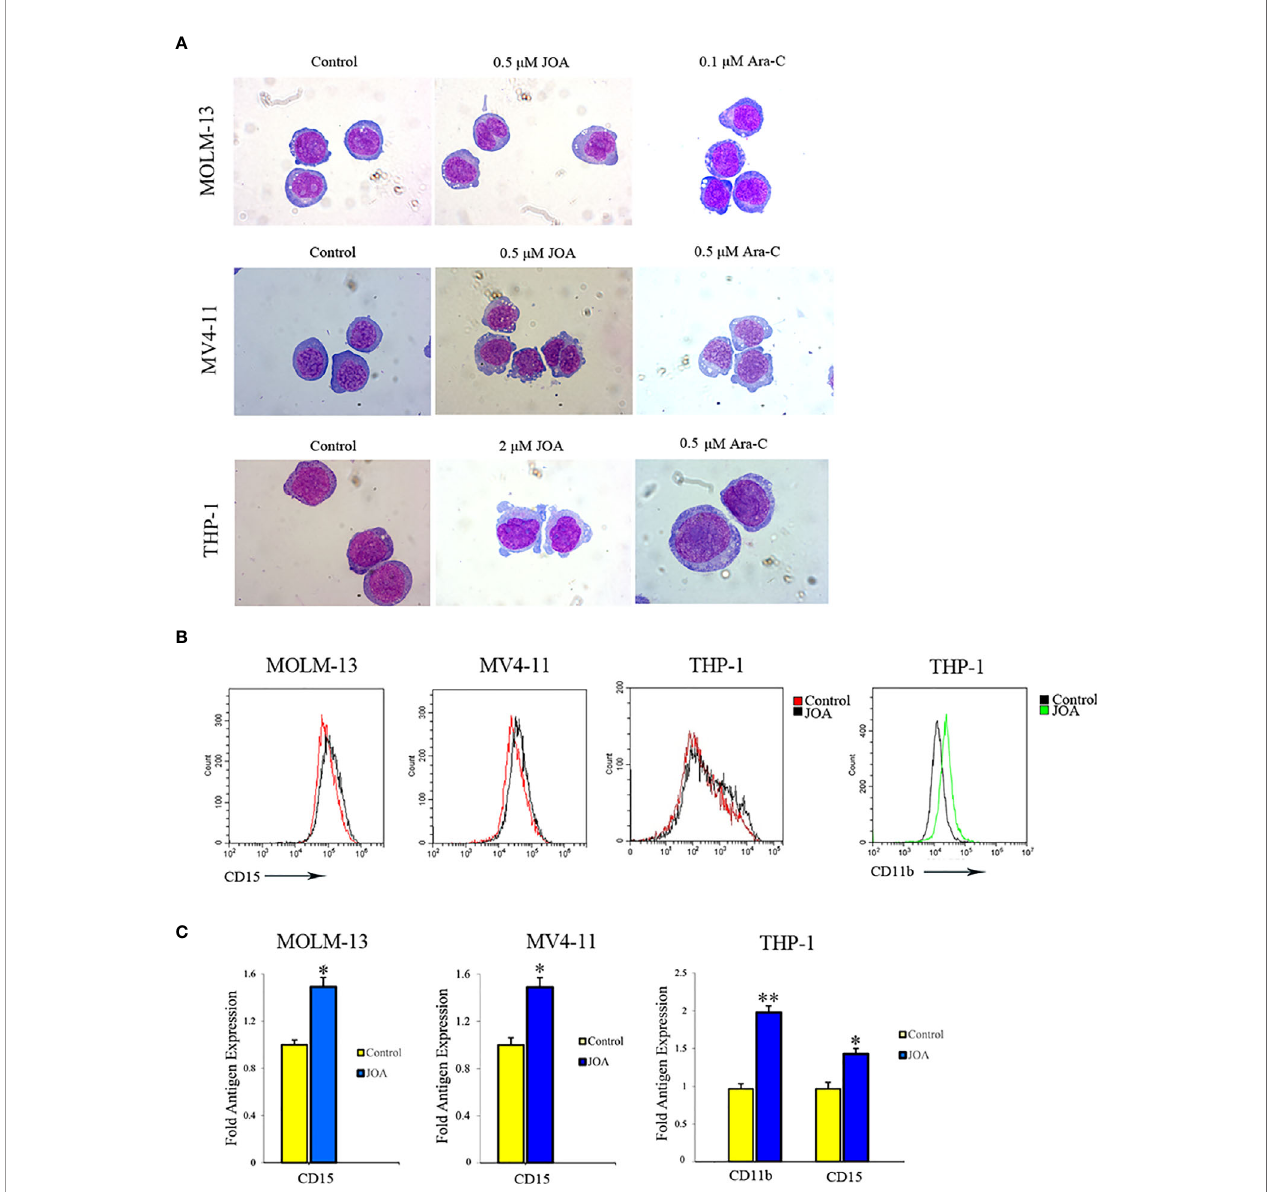
FIGURE 5 | JOA induces differentiation of MV4-11, MOLM-13 and THP-1 cells. (A) Wright-Giemsa staining images of cells captured by oil immersion lens (×1,000). (B) The expression of cell-surface antigens was measured by fl ow cytometry. (C) Graph bars show the mean fl uorescence intensity (MFI) of antigens. MV4-11, MOLM-13 and THP-1 cells were incubated with 0.5, 0.5 or 2 m M JOA, or Ara-C at the concentration of 0.1, 0.5 or 0.5 m M for 72 h, respectively (*p < 0.05, **p < 0.01). The fi gures are representative of three independent